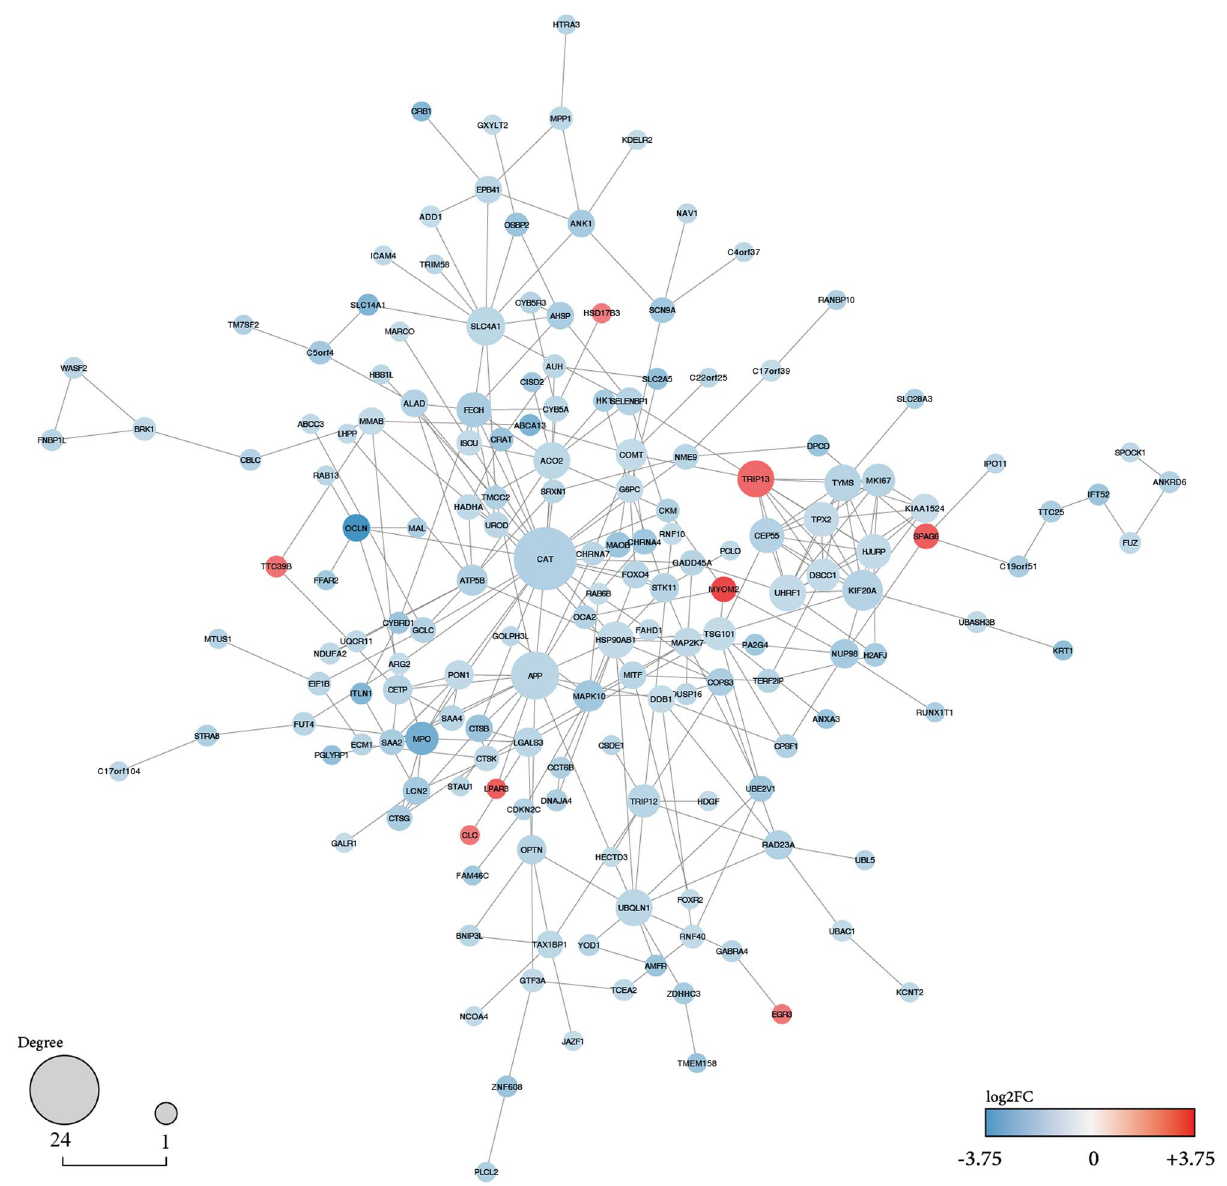
Figure 4. Protein–protein interactions network with DEGs for brain metastasis in SCLC. Up and down- regulated candidate genes are coloured on the scale of logFC. Log2FC is an indicator of the expression level of these genes since logFC = 3.75 for the most up-regulated gene in BM SCLC patients and logFC = − 3.75 for the most down-regulated gene. The nodes’ size characterises the connectivity degree for identifying the critical hub genes ( CAT and APP ). Unconnected nodes are trimmed from the